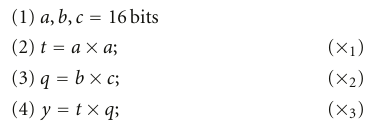
Figure 3: Specification with multiple data-width requirements.